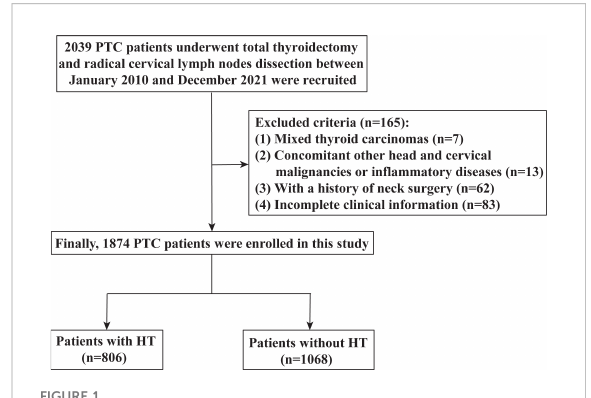
FIGURE 1 The fl owchart of the inclusion and exclusion criteria for the